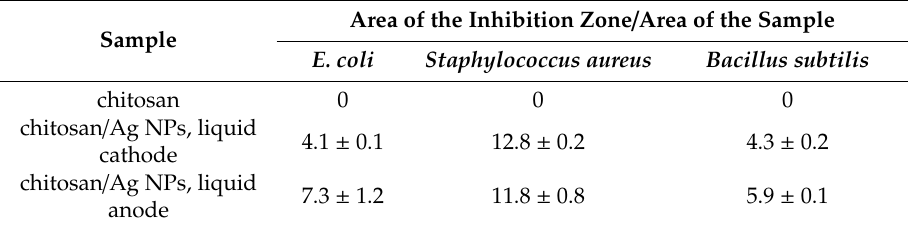
Table 2. The bactericidal e ffi ciency of chitosan and chitosan / Ag NP foils.